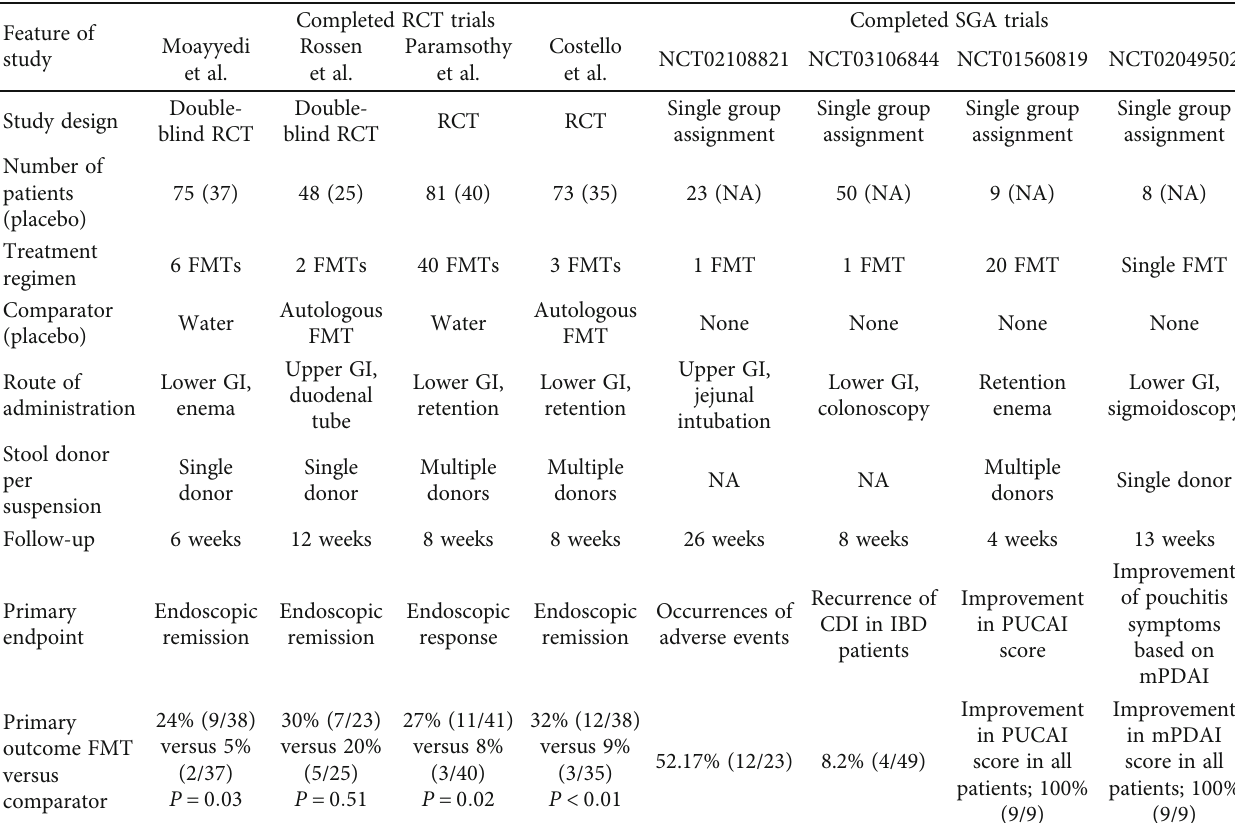
Table 1: Completed clinical trials investigating FMT as a potential therapy for IBD.